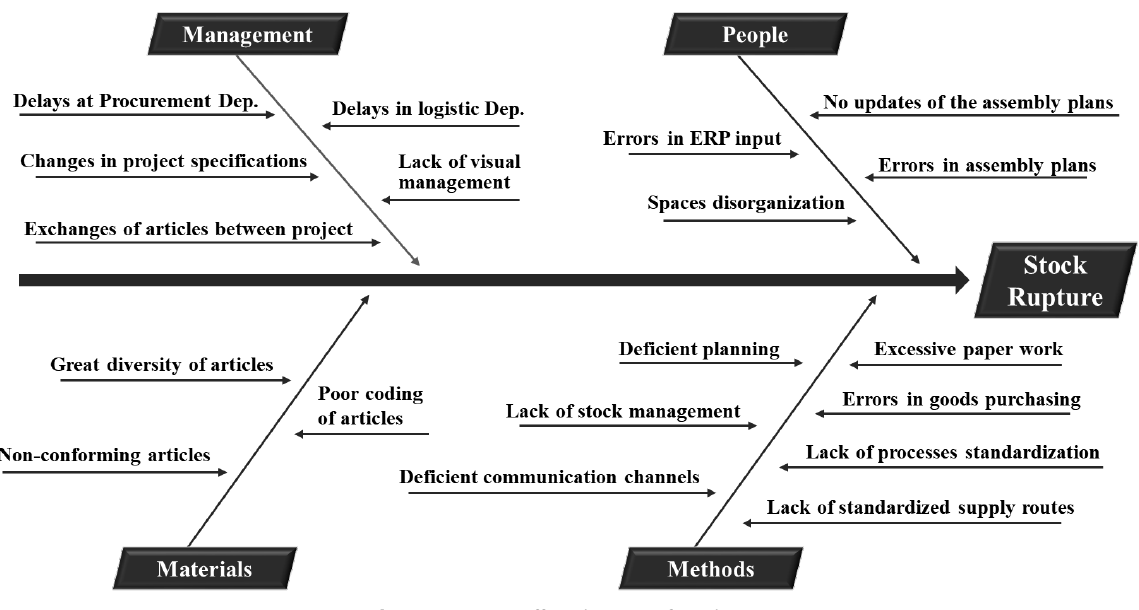
Figure 3. Cause-effect diagram of stock